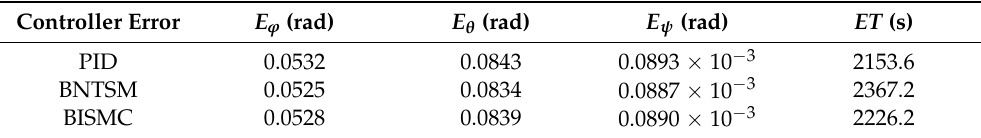
Figure 4. Euler angles in Scenario 1 without wind compensation.